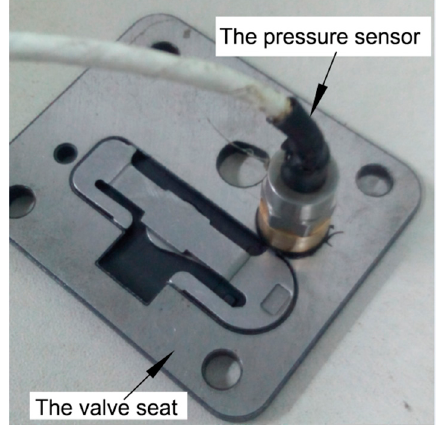
Figure 2. The installation of pressure sensor.